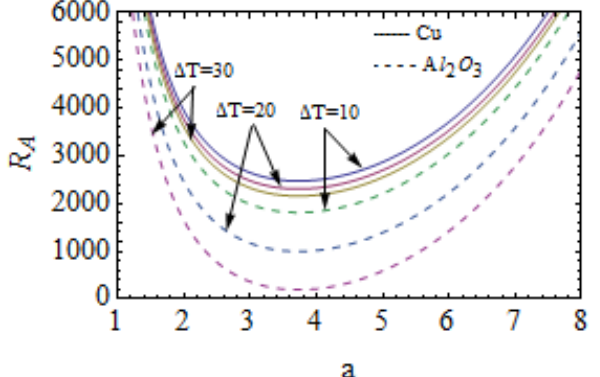
Figure 1. Impact of temperature difference